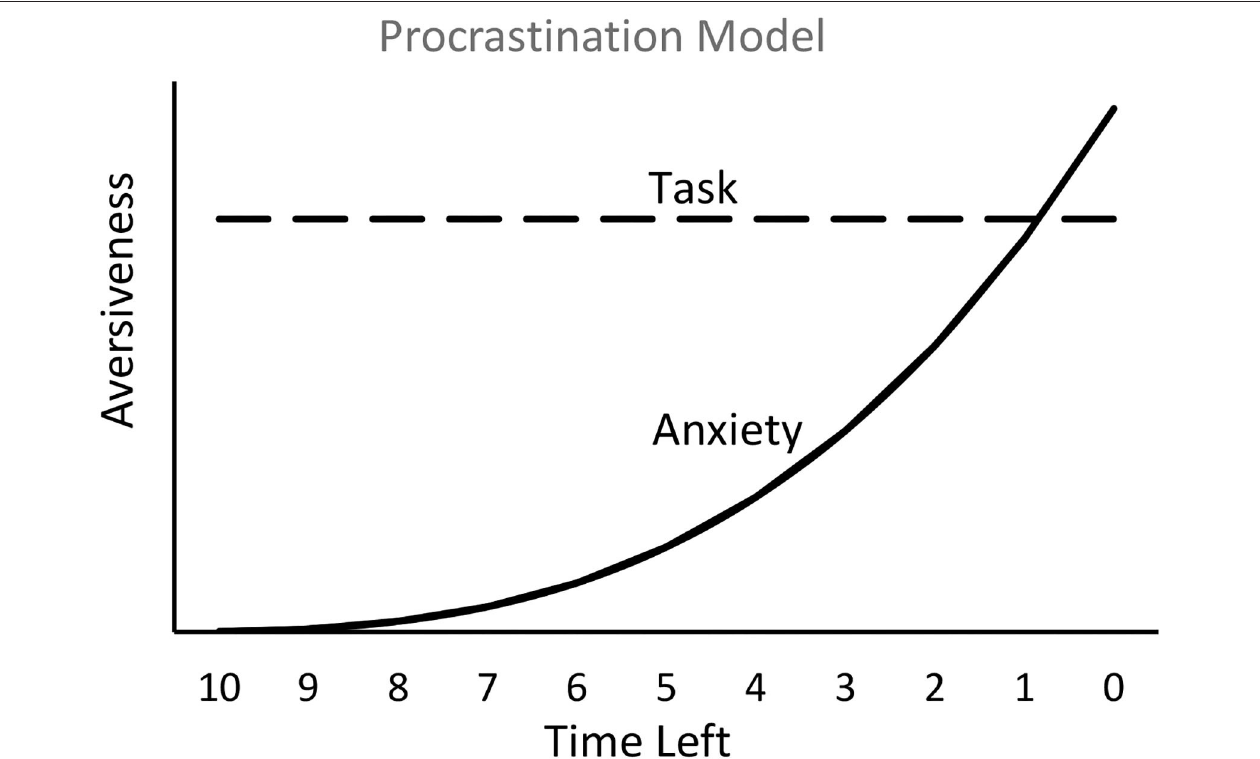
FIGURE 4 | Hypothetical plot of the relation between the interaction of two emotions, the aversiveness of the task and the aversiveness of anxiety resulting from the fear of doing poorly or of missing the deadline. The model predicts that work on the task will begin when anxiety approaches the aversion to the task.